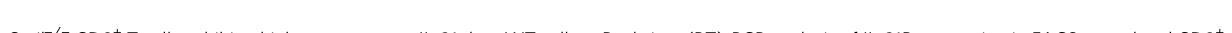
Fig. 4 Grail − / − CD8 + T cells exhibit a higher response to IL-21 than WT cells. a Real-time (RT)-PCR analysis of IL-21R expression in FACS-sorted and CD8 + T cells from TILs after anti-CD3 restimulation. Results for target genes are presented after normalising to β -actin and shown as mean ± SEM. ( n = 3). b , c Naive WT and Grail − / − CD8 + T cells were activated with anti-CD3 alone or with IL-21. b Proliferation of WT and Grail − / − CD8 + T cells was assayed 72 h after activation by adding [ 3 H]-thymidine to the culture for the last 8 h. c Cells were harvested for RT-PCR analysis 24 h after activation. Results for target genes are presented after normalising to β -actin and shown as mean ± SEM. The mRNA expression level in WT CD8 + T cells activated by anti-CD3 alone was set as 1. d , e Naive WT and Grail − / − CD8 + T cells were stimulated with anti-CD3 in the presence or absence of IL-21 for 3 days. d IFN- γ and granzyme B (GzmB) protein production after determined by ELISA and fl ow cytometry. e Flow cytometry staining was performed for CD132 and IL-21R α expression. f – h WT, Grail − / − and Grail − / − Il21 − / − mice were inoculated with EG-7 tumour cells and analysed 17 days later. f Tumour size was measured and calculated as in Fig. 1a. g , h TILs were stained and analysed as described in Fig. 1. Results are shown on bar graphs as mean ± SEM as well as individual mice per